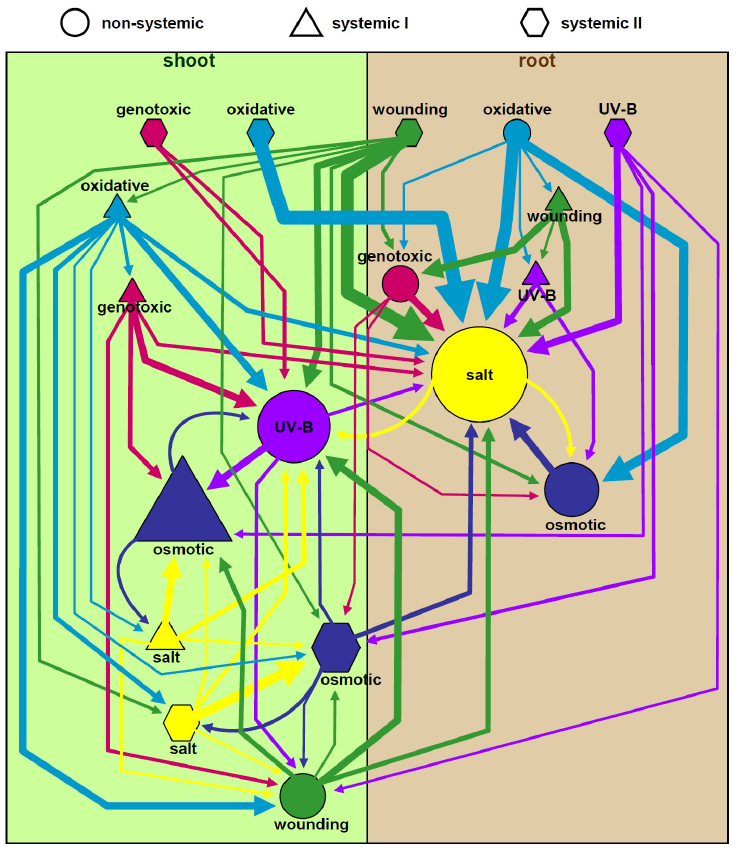
Figure 3. Pair-wise network of gene overlap between the six stresses. Reciprocal comparison of a non-systemic (circle), type I systemic (triangles) or type II systemic (hexagons) responses. The size of each dataset (node) and connecting arrows (edges) represent the overlap of genes shared between two datasets. The sizes of each node or edge are proportional to the amount of overlap (10% to